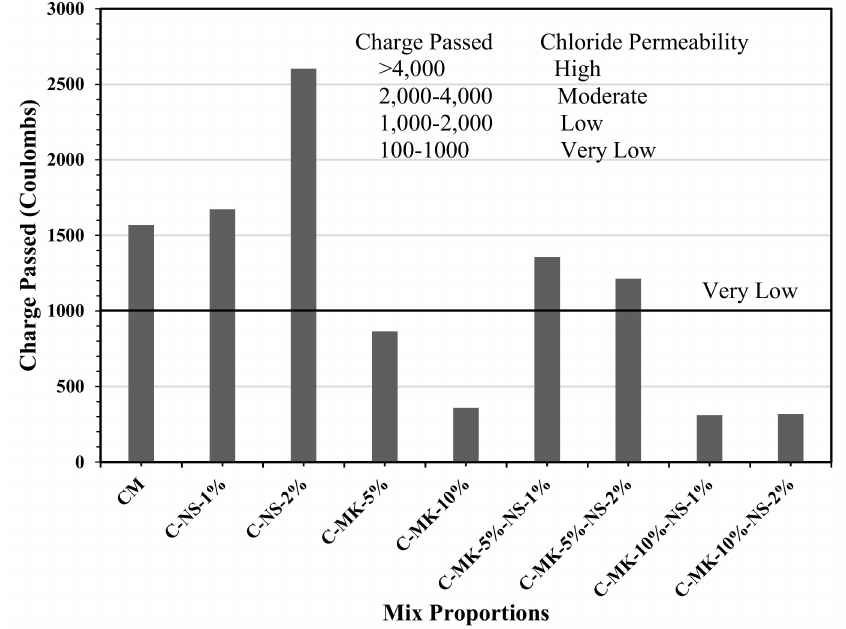
Figure 4. Rapid Chloride Permeability (Coulombs) for all concrete